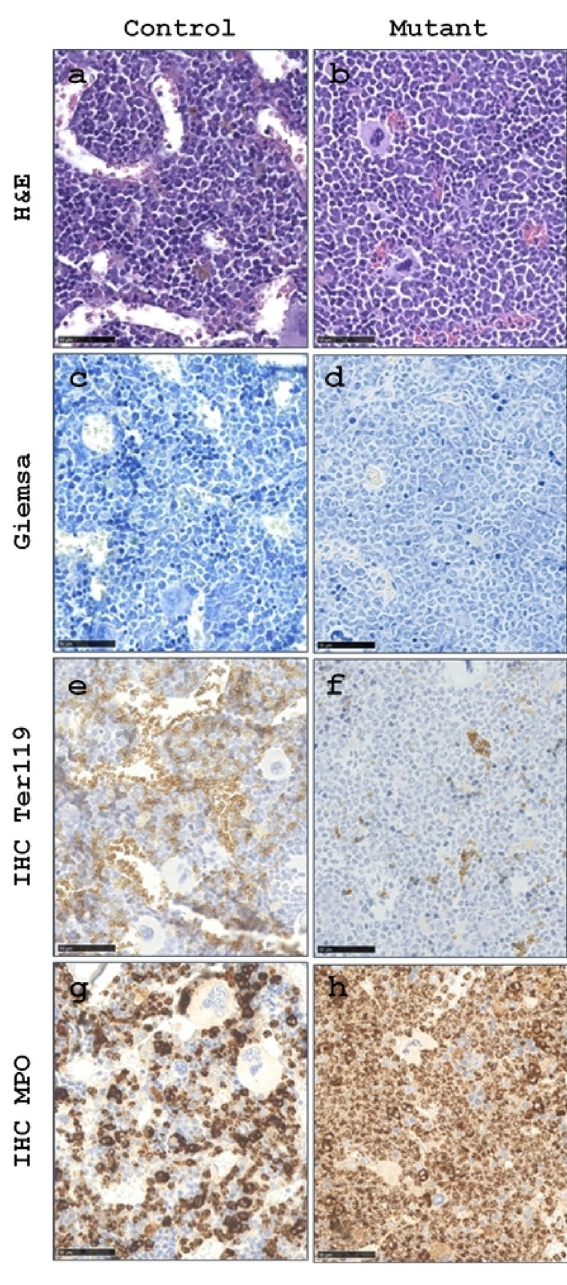
Figure 5. Representative images of bone marrow of the lumbar vertebrae from control ( a , c , e , g ) and mutant ( b , d , f , h ) mice. H&E and Giemsa stained sections ( a – d ) show an increase in hematopoietic cell density with a corresponding decrease in vascularization in the mutant compared to the control. Immunohistochemistry (IHC) using the Ter119 marker for mature and immature erythrocytes reveals the expected proportion of the erythrocyte to myeloid cells ( E : M) ratio in the control animal ( e ), in contrast, a decreased amount of erythrocytes was detected in mutant ( f ). Whereas the IHC using the MPO marker demonstrates an increase in the number of myeloid cells, a shift to ( M : E) ratio, in the mutant ( h ) compared to the control shown in ( g